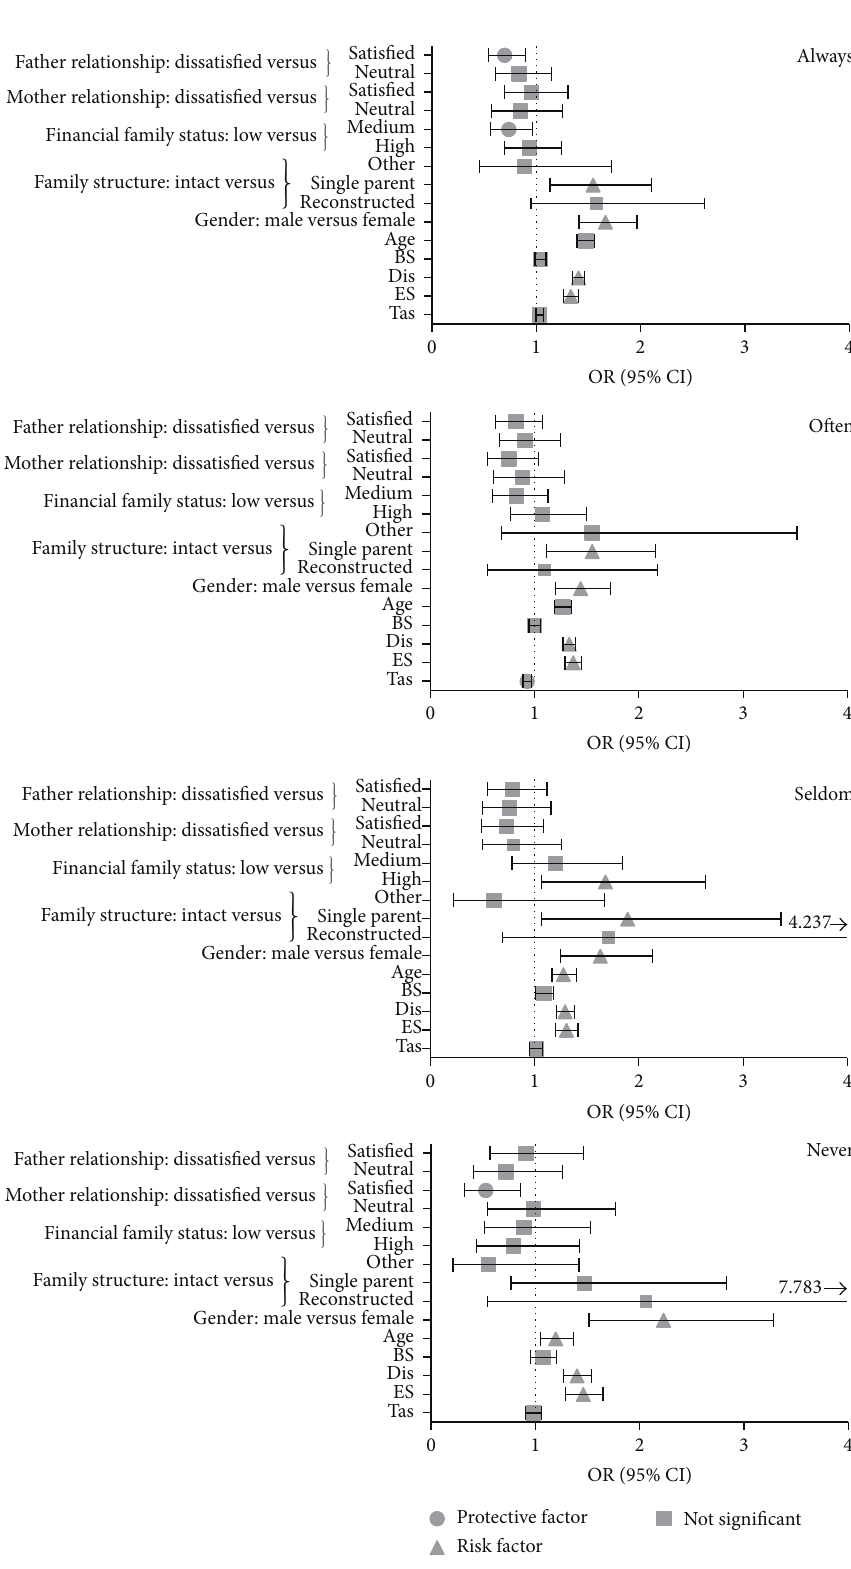
Figure 1: Multivariate logistic model for substance use stratified for parental control with SSS subscales (Model